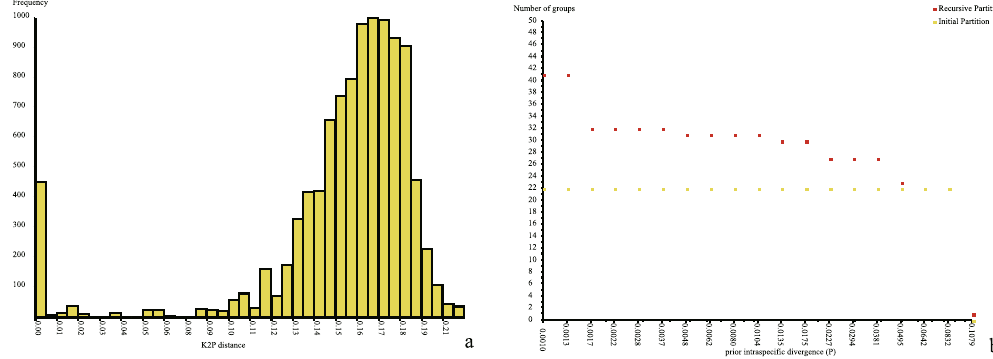
Figure 1. ABGD species delimitation. ( a ) Frequency histogram of K2P pairwise distances. ( b ) Partitions under different prior intraspecific divergences.